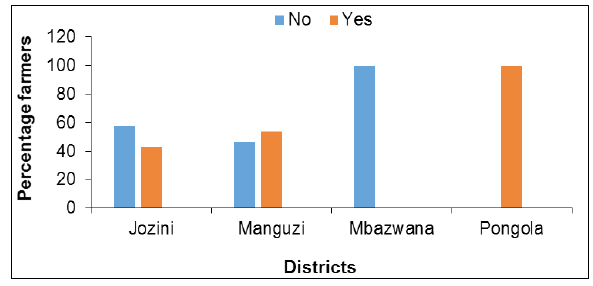
Figure 2: Residue removal before planting groundnuts by subsistence farmers in four districts of northern KwaZulu-Natal (chi-square: d.f.=3; p =1.769).